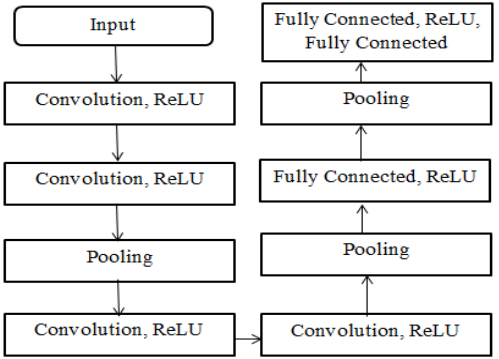
Figure 4. Block Diagram for VGGNet Operation.